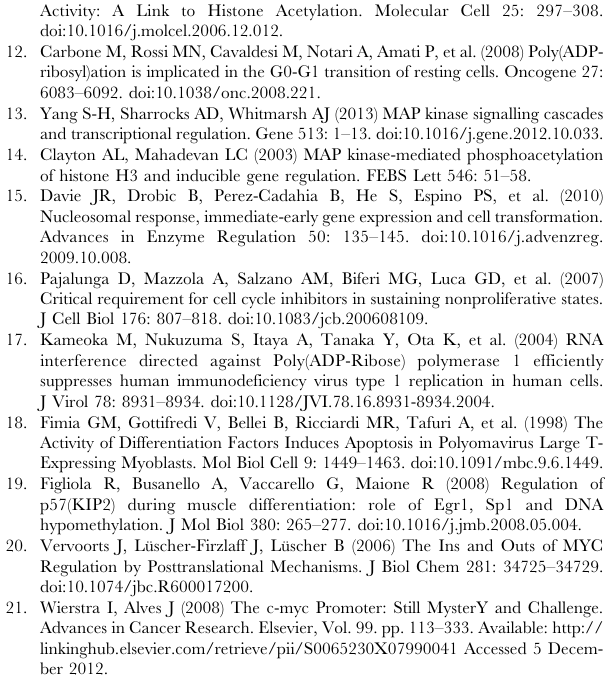
Figure S2 Poly(ADP-ribosyl)ation in cells stably knocked-down for PARP-1. Mouse C3H10T1/2 fibroblasts expressing the PARP-1 short hairpin RNA vector (shPARP-1) or the empty vector (Control) were made quiescent by serum deprivation for 72 hrs. After serum stimulation, cells were collected and nuclei were isolated by incubation with buffer A (10 mM HEPES pH7.9; 10 mM KCl; 0.1mM EDTA; 0.1 mM EGTA; 1 mM DTT; 10% NP-40; 0.5mM PMSF). After centrifugation, nuclei were re-suspended in RIPA buffer (150 mM NaCl; 50 mM Tris HCl, pH 8; 1% NP-40; 0.5% Na- Deoxycolate; 0.1%SDS) and quantified by Lowery assay (Bio-